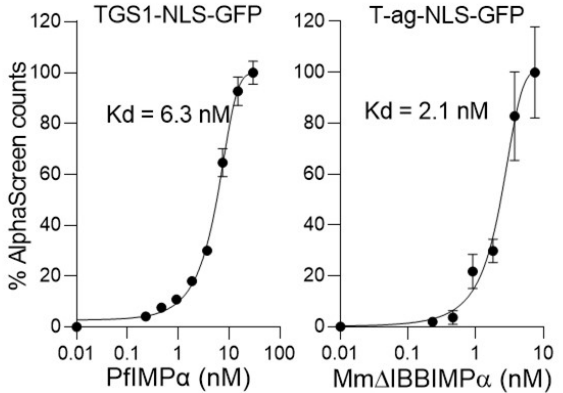
Figure 1. PfIMP α shows high affinity binding to the TGS1 NLS, comparable to that for Mm ∆ IBBIMP α . AlphaScreen technology was used to determine the K d value of NLS-GFP (30 nM) binding to biotinylated-GST-IMP α s (5 nM). Data points in the figures represent the AlphaScreen signal for NLS-GFP and IMP α interaction from a single typical experiment from a series of three independent experiments. Pooled data showed K d values of 6.5 ± 0.2 and 2.6 ± 0.5 nM (mean ± SEM, n = 3) for